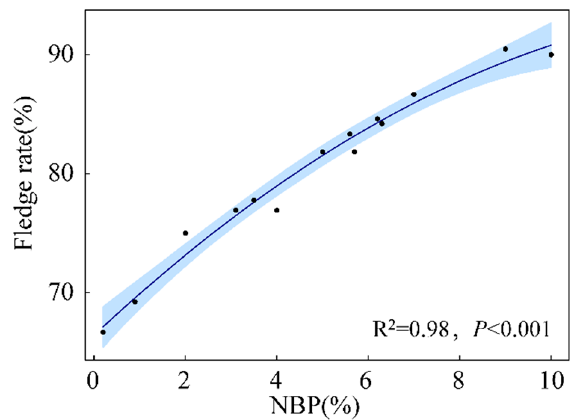
Figure 7. The relationship between nymph biomass proportion (NBP) and fledge rate of Asian short-toed lark ( Alaudala cheleensis ) nestlings ( n = 45). NBP is the proportion of the daily grasshopper nymph biomass relative to the total biomass measured on all survey days. The blue area is the confidence interval.